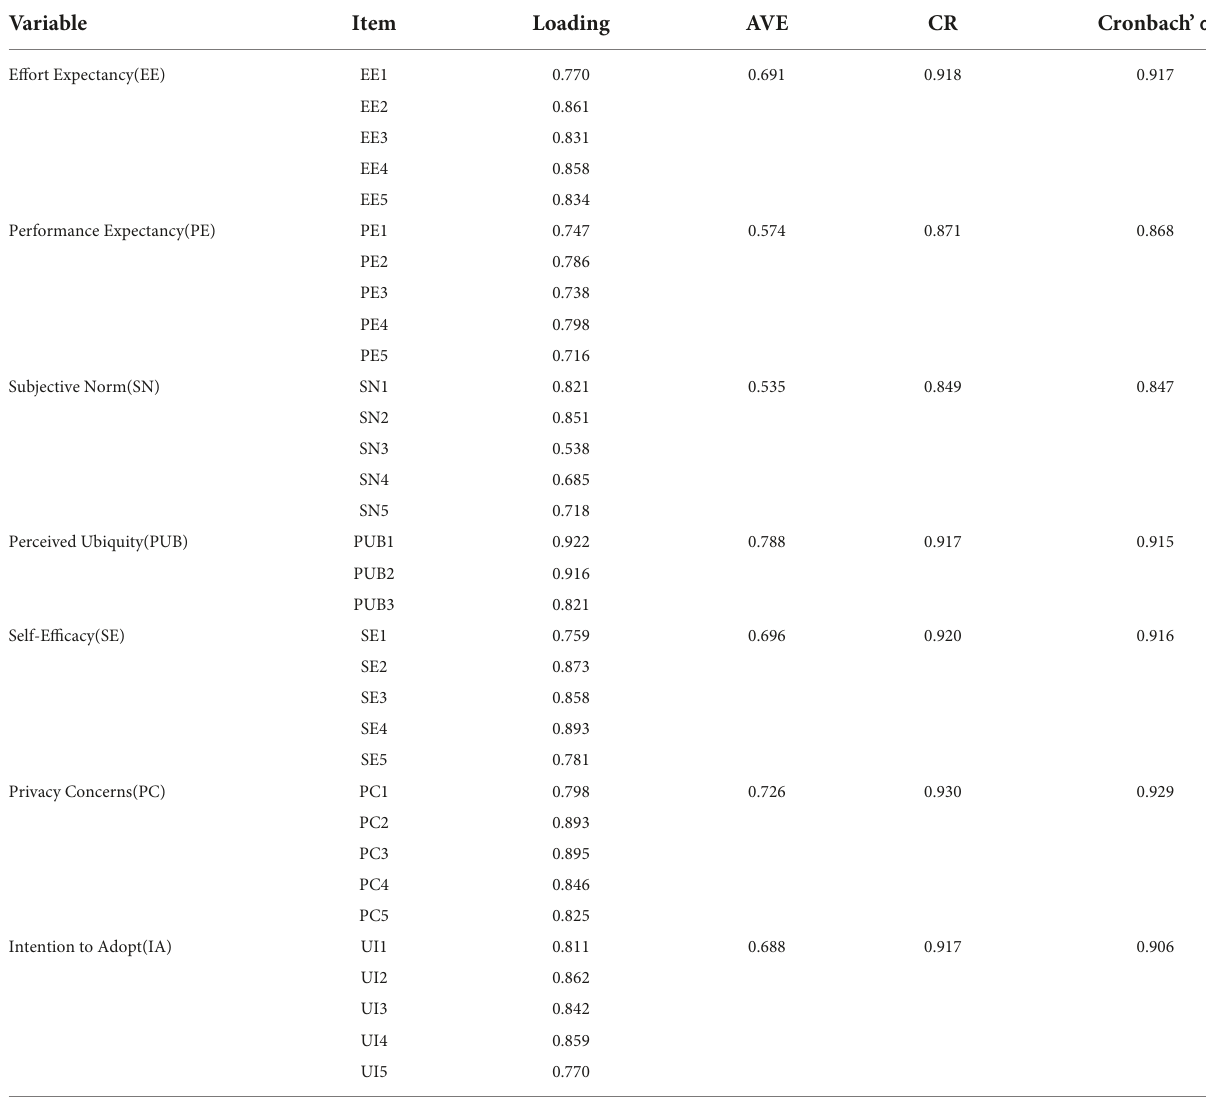
TABLE 6 Item loadings, AVE, composite reliabilities, and alpha.